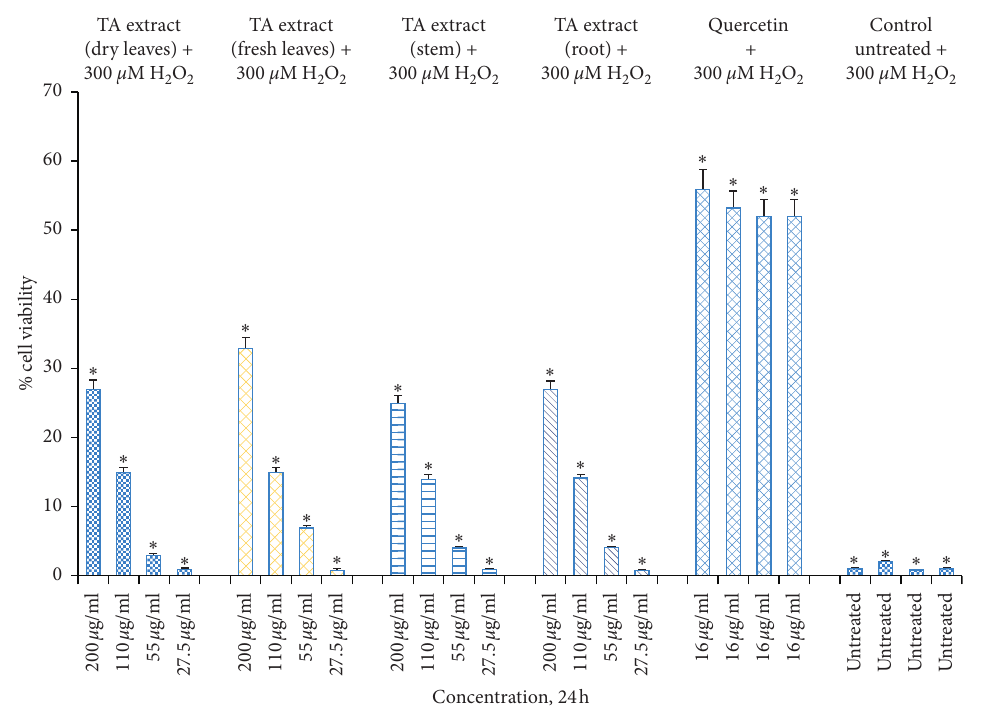
Figure 6: Cell viability determined by MTT assay. Hs27 skin fibroblasts were seeded at a density of 10,000 cells/well in 96-well plates and allowed to incubate overnight to attach to the surface. Next day, treat the cells with TA extracts (fresh and dry leaf, stem, and root extracts) for 24h along with quercetin as positive control (16 μ g/mL) and control as untreated. After the completion of treatment, expose the pretreated cells with 300 μ M of H ₂ O ₂ for 1h. Data shown as mean ± SEM; n � 3, ∗ p < 0 .